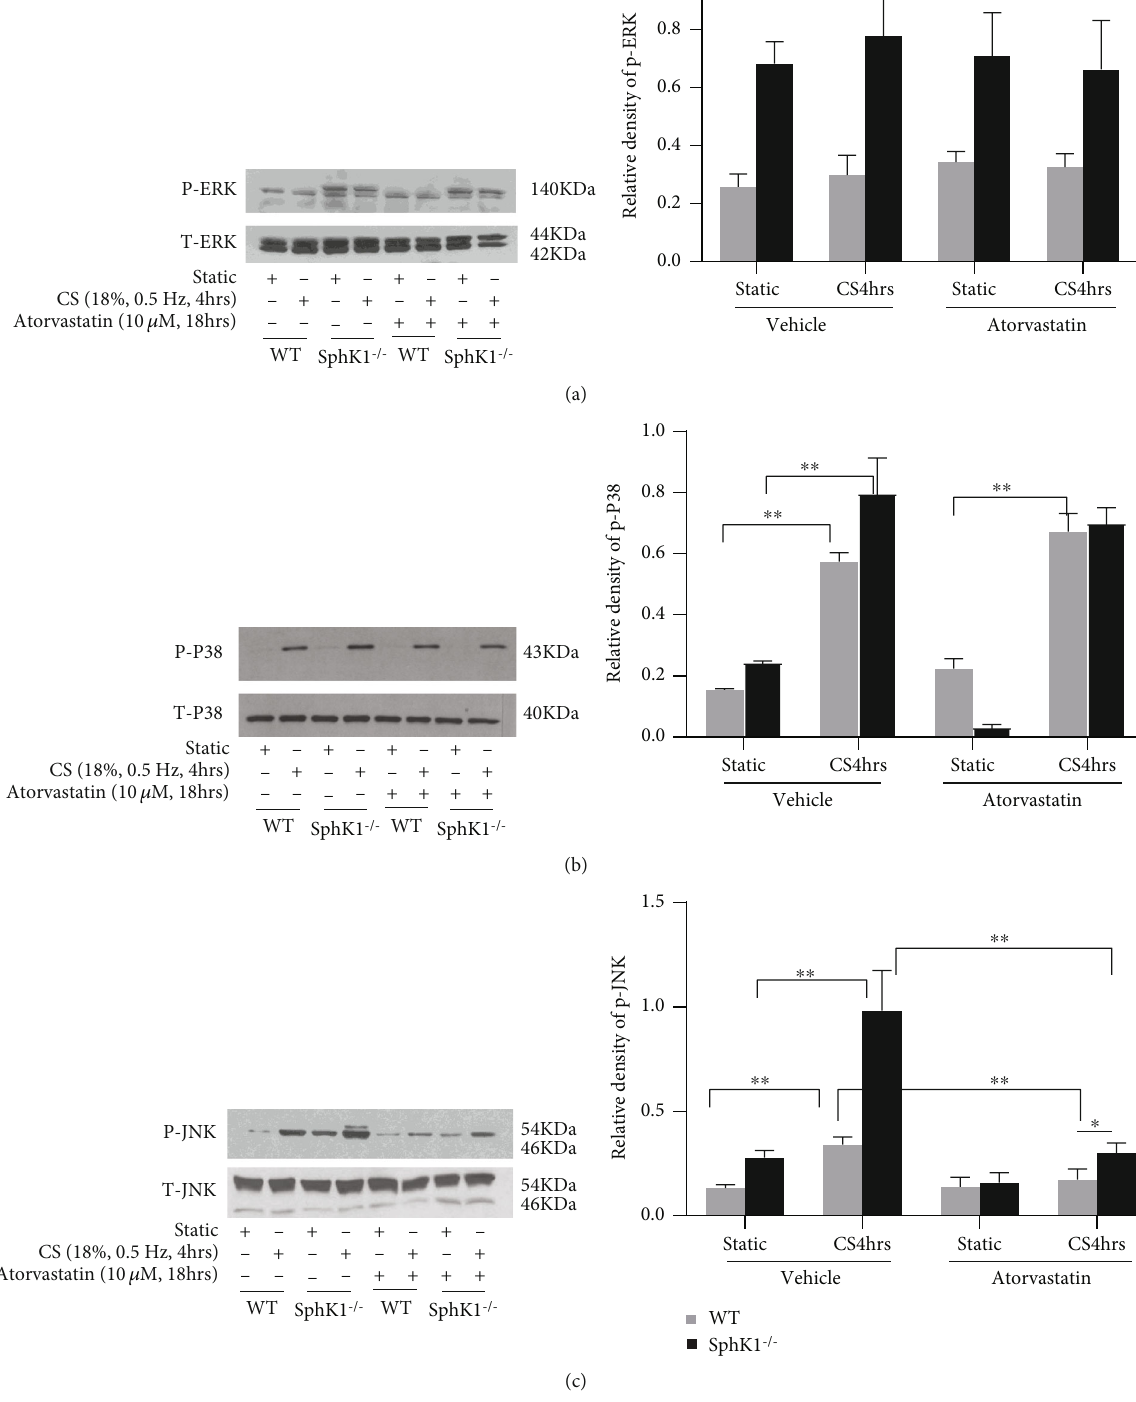
Figure 5: Atorvastatin attenuated cyclic stretch- (CS-) mediated MAPK phosphorylation, and SphK1 knockout reversed this e ff ect. After CS fi nished at indicated time, the cellular lysates were harvested for western blotting. Compared to the static control, CS signi fi cantly induced (b) P38 and (c) JNK phosphorylation in mouse WT ECs. The MAPK phosphorylation was signi fi cantly attenuated by pretreatment of atorvastatin. Compared with WT endothelial cells, SphK1 -/- cells showed enhanced CS-mediated P38 and JNK phosphorylation. Moreover, CS-mediated P38 and JNK phosphorylation levels in SphK1 -/- ECs were signi fi cantly higher than those in WT ECs after treatment of atorvastatin. ( ∗ P < 0 : 05 , ∗∗ P < 0 : 01